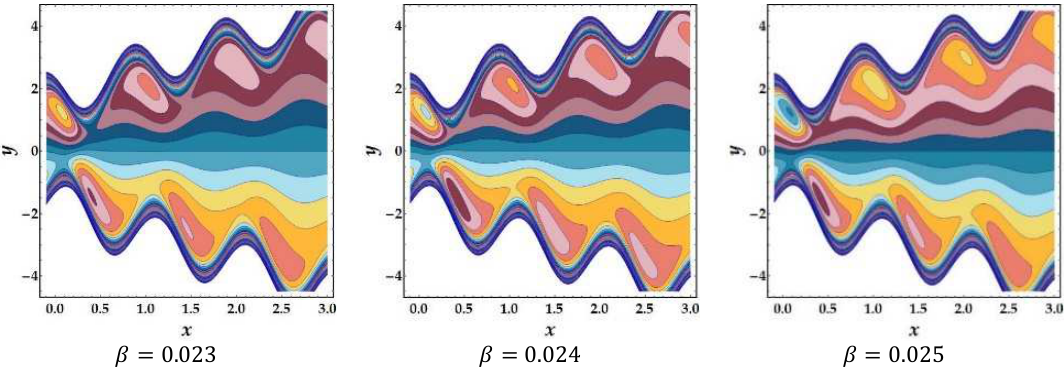
Figure 11. The behavior of Streamlines for different values of inclined angle β